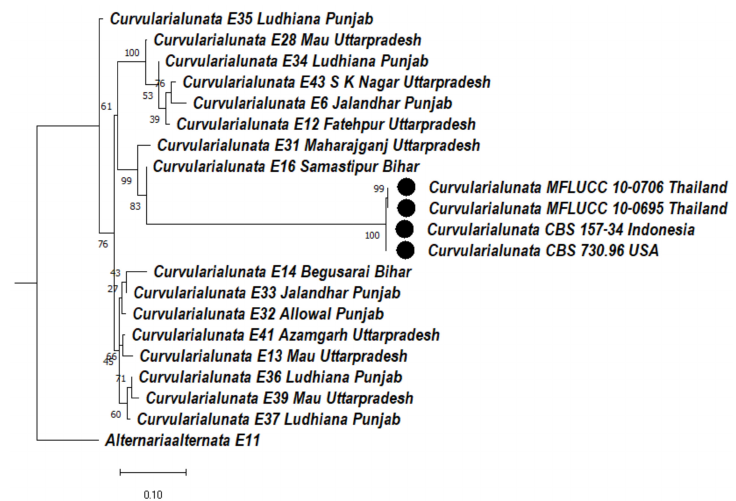
Figure 8. Dendrogram constructed from maximum likelihood method based on combined internal transcribed spacer (ITS), large subunit gene regions (LSU), and glyceraldehyde-3-phosphate dehydro- genase (GAPDH). Sequenced data of the Curvularia lunata isolates were inferred with Raxml based on GTR + Gamma model. Numerical value presented in the node indicates bootstrap value with a 1000 non-parametric bootstrap replicate analysis. The symbol • denotes as ‘ ex-type ’ closely related species sequences obtained from GenBank. Alternaria alternata used as an